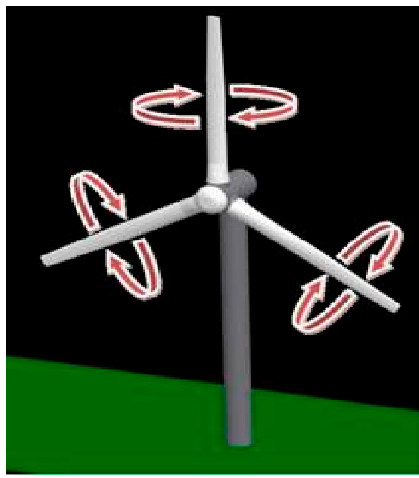
Figure 18. Wind turbine blade pitch angle control.